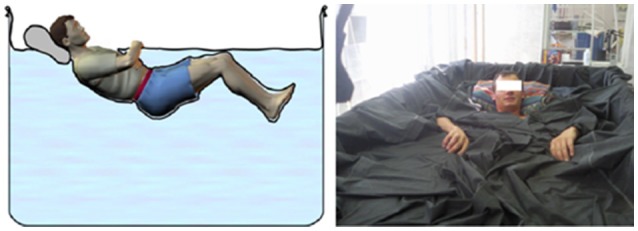
Dry immersion experiment.